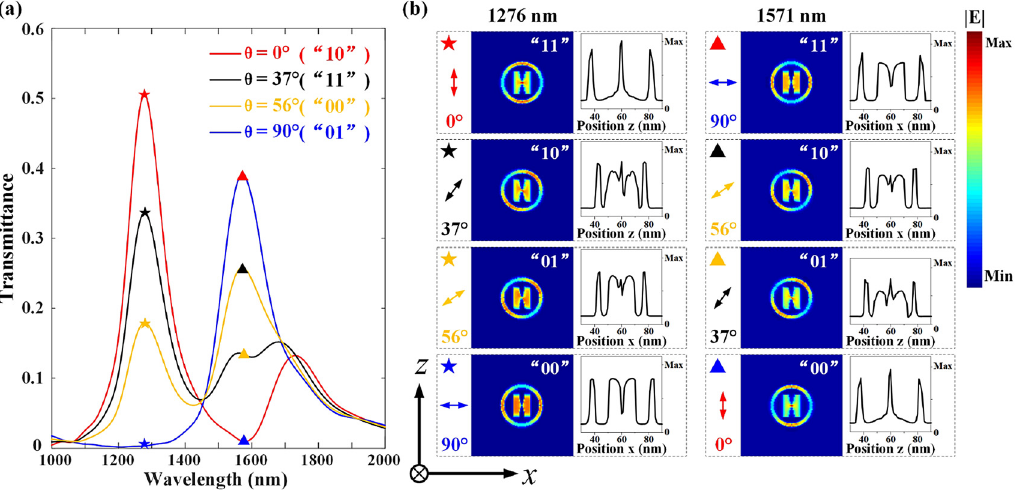
Figure 5: The amplitude responses in the transmitted spectra of the dual-wavelength 2-bit digital metasurface, as well as their coding